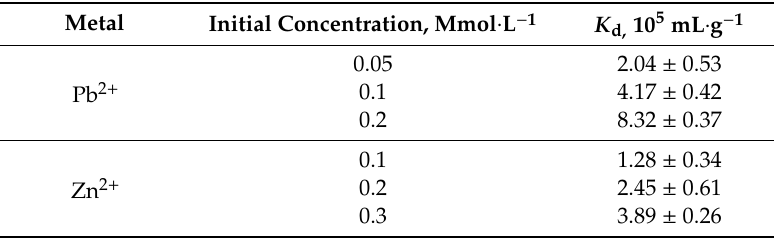
Table 7. The selectivity of titanium phosphate for lead and zinc ions at a high concentration of Ca 2 + ions (480 mg · L − 1